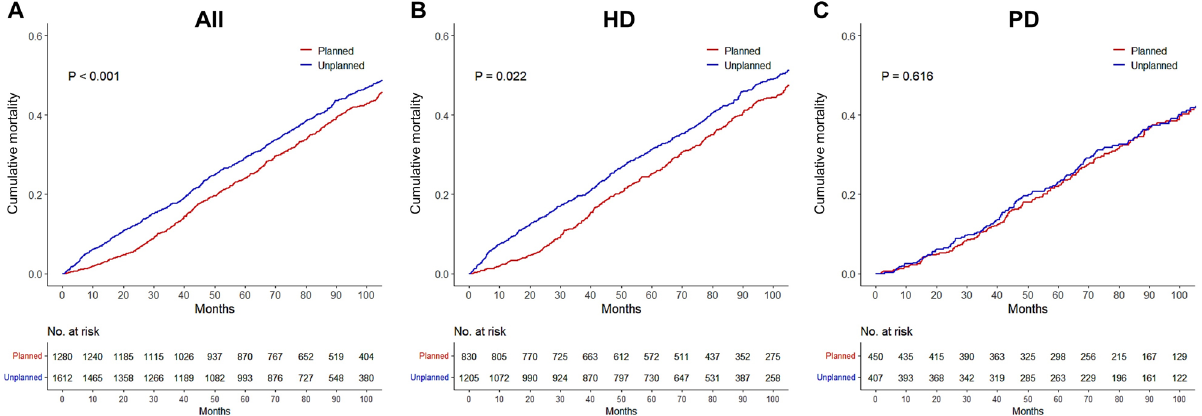
Figure 1. Kaplan–Meier curves for the cumulative risk of death according to planned dialysis. ( A ) All patients ( B ) Patients undergoing hemodialysis ( C ) Patients undergoing peritoneal dialysis. HD hemodialysis, PD peritoneal dialysis.